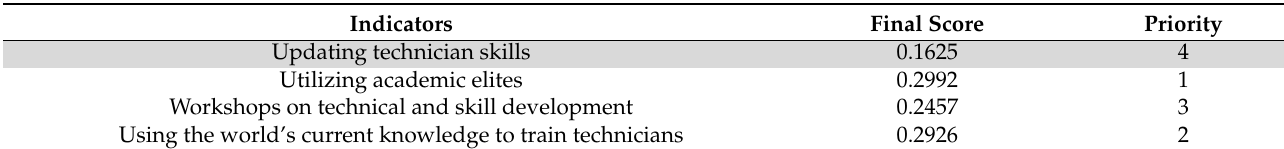
Table 16. Priority related to attention to training